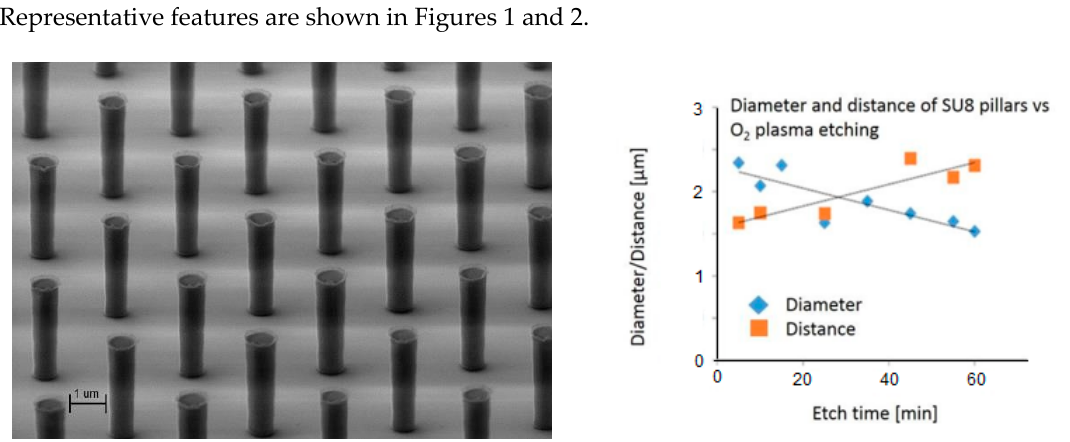
Figure 1. Representative microstructures ( left ) and relationship between the O 2 plasma etching time and the feature size of the pillars ( right ).